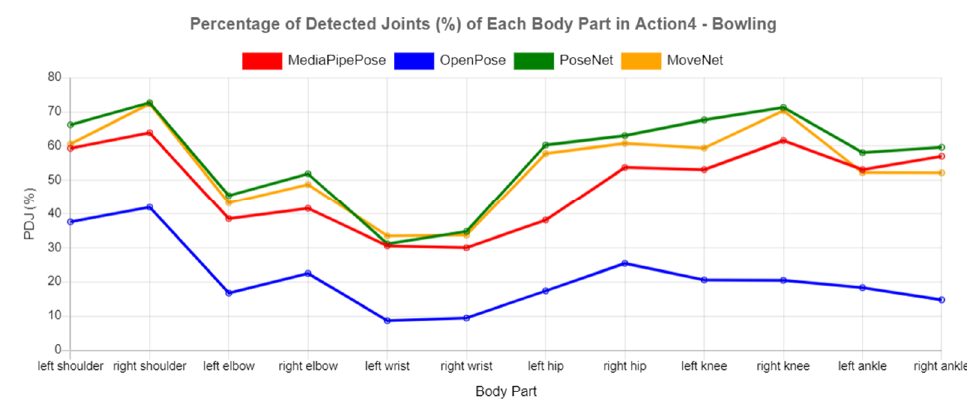
Figure 10. PDJ for each body part in Action 4–bowling.